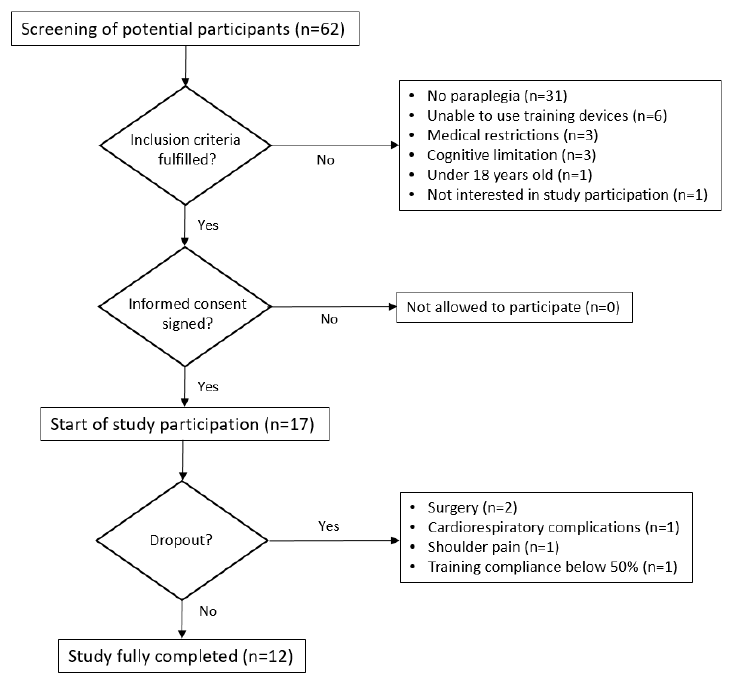
Figure 2. Flow chart of the recruitment process.